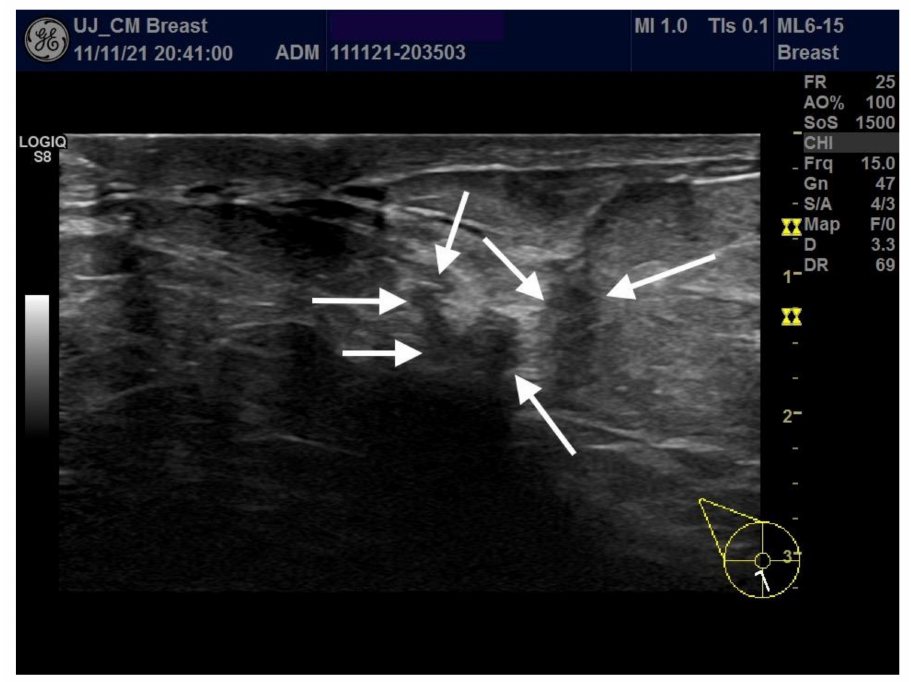
Figure A3. Ultrasound image of the BI-RADS-US class 4b, diabetic mastopathy-type lesion measuring 12 × 7 × 6 mm in a 62-year-old